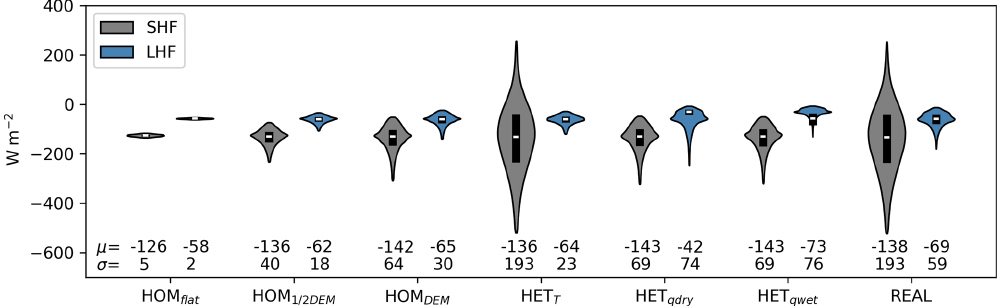
Figure 4. Violin plots to show spatial variability of time average fluxes (95% confidence interval) within the domain for the SHF (grey) and LHF (blue). The numbers indicate the domain average ( µ ) and standard deviation ( σ ). Fluxes pointing towards the surface are